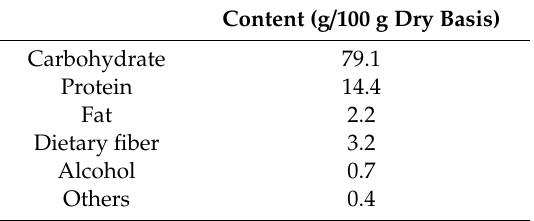
Table 1. The nutritional component of powder containing both sake cake and rice